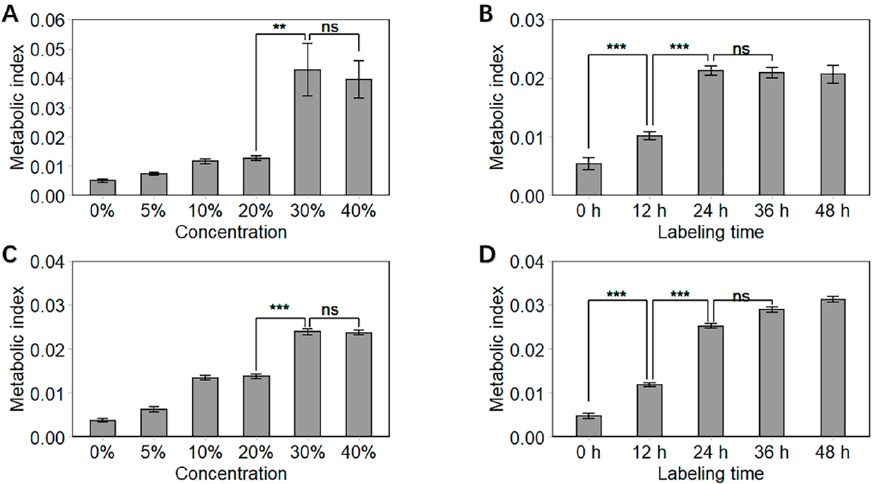
Figure 3. Single-cell metabolic index of HCC827 ( A , B ) and MCF-7 ( C , D ). Cells were incubated at various D 2 O concentrations for 24 h ( A , C ) and in 30% D 2 O for different durations ( B , D ). Statistical significance was calculated ( t test) and marked accordingly. ***: p ≤ 0.001; **: p ≤ 0.01; ns: p > 0.05, no significance. Error bars represent the standard deviation of at least 10